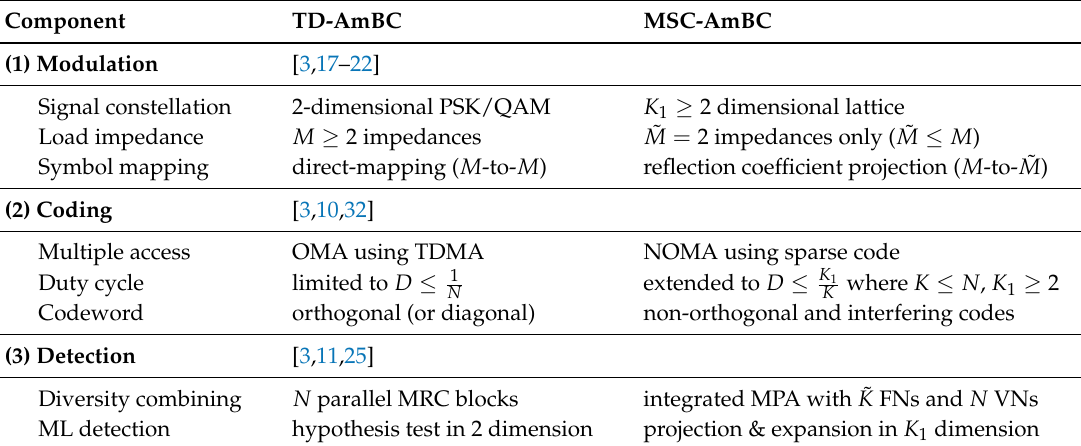
Figure 8. Block diagram of AmBC systems in view of modulation, coding and detection. Table 1. Comparison of AmBC systems evaluated in numerical